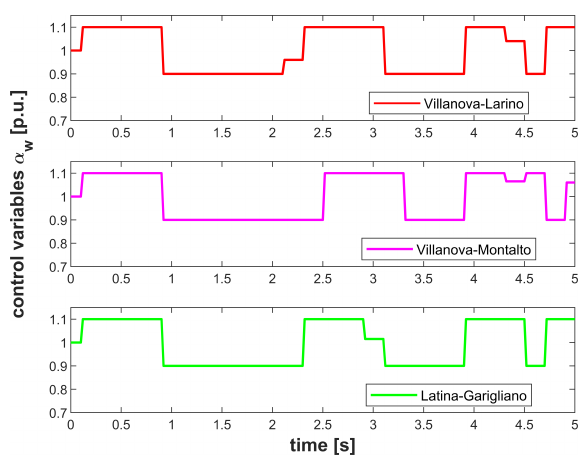
Figure 9. Control actions for the three clusters of